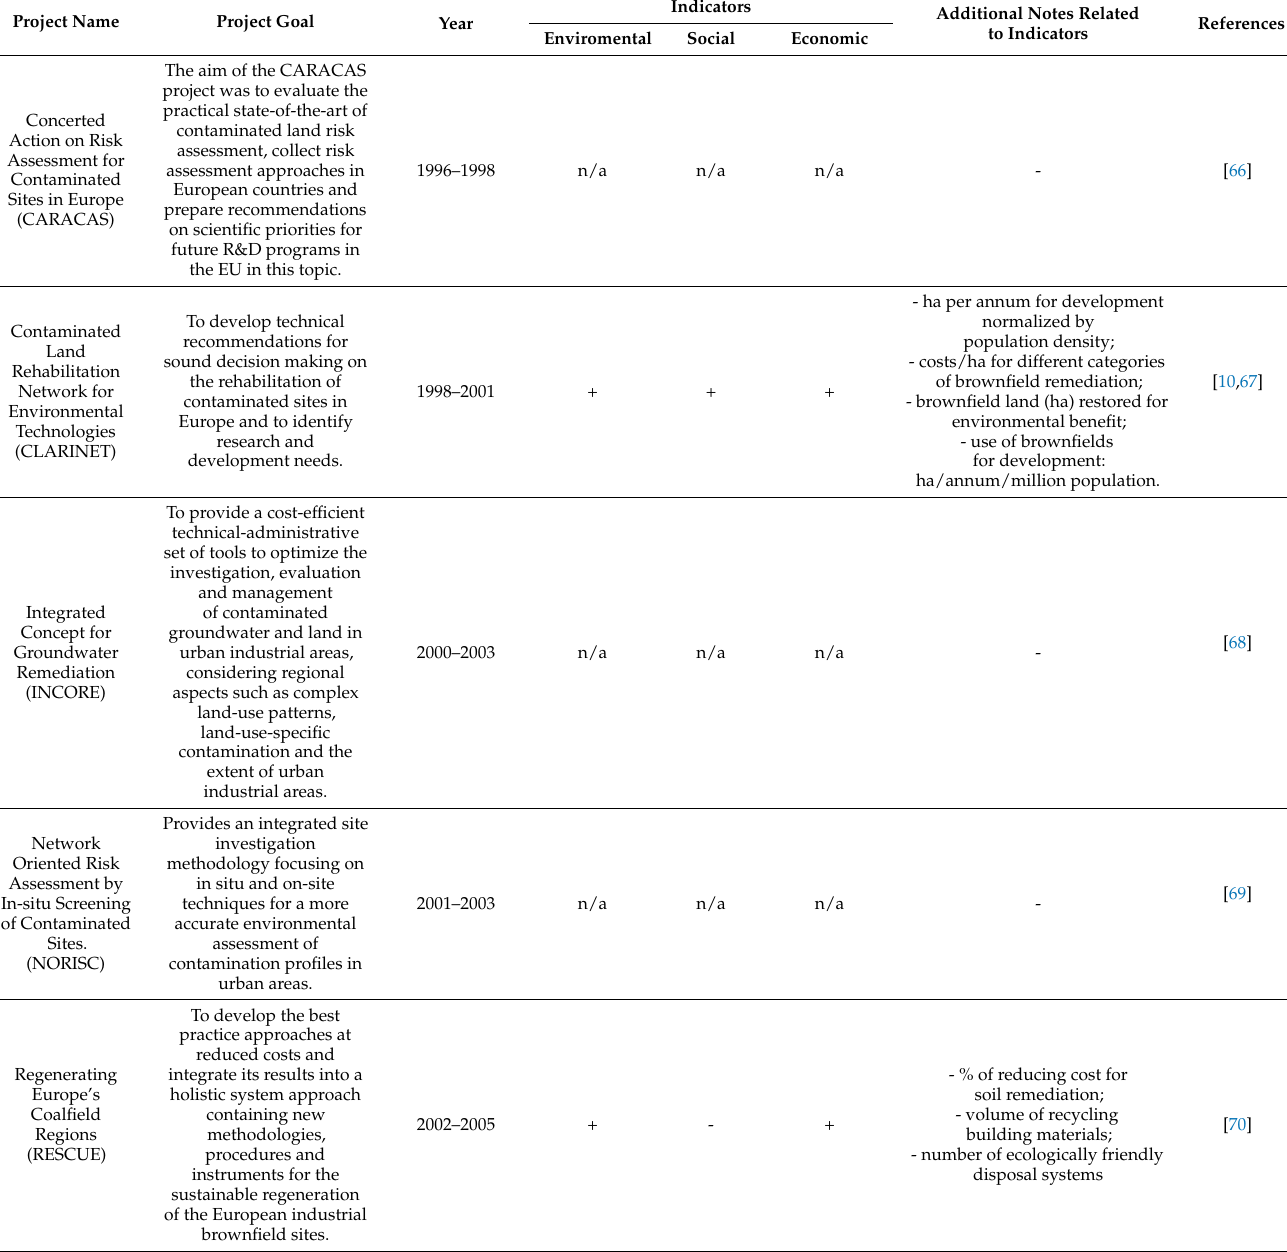
Table 5. The most important projects on brownfields in the targeted regions and in the Central and Eastern